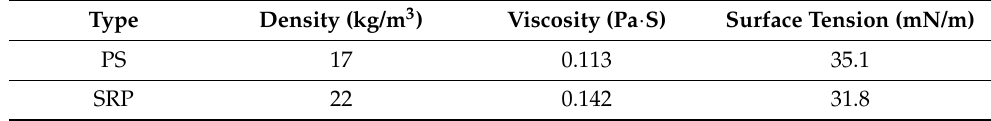
Table 7. Properties of the